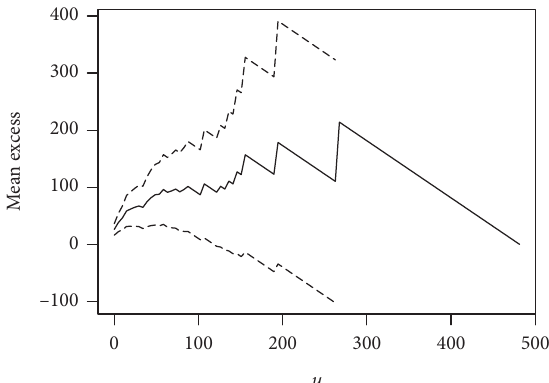
Figure 2: Mean excess plot of damage areas.